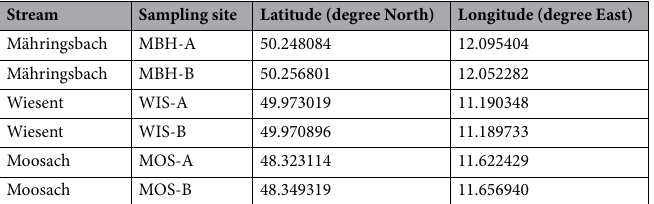
Table 1. Overview of sampled streams and study sites with respective GPS coordinates.